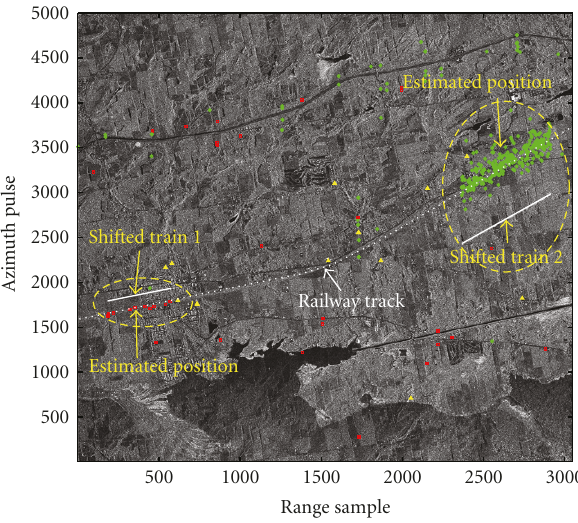
Figure 8: Estimated azimuth positions of two trains (Trenton, ON) overlaid on the SAR image. Green markers are receding targets and red markers denote approaching targets.